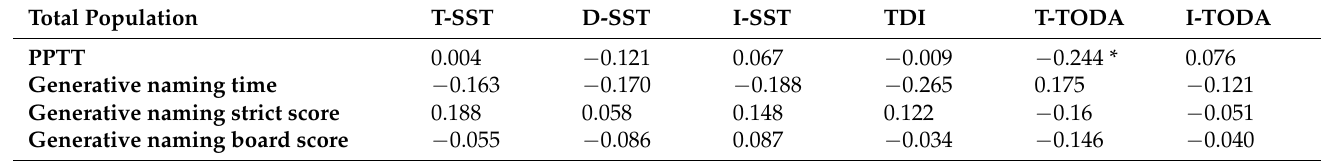
Table 3. Correlation matrix among variables. T = Threshold, D = Discrimination and I = Identification. * p <